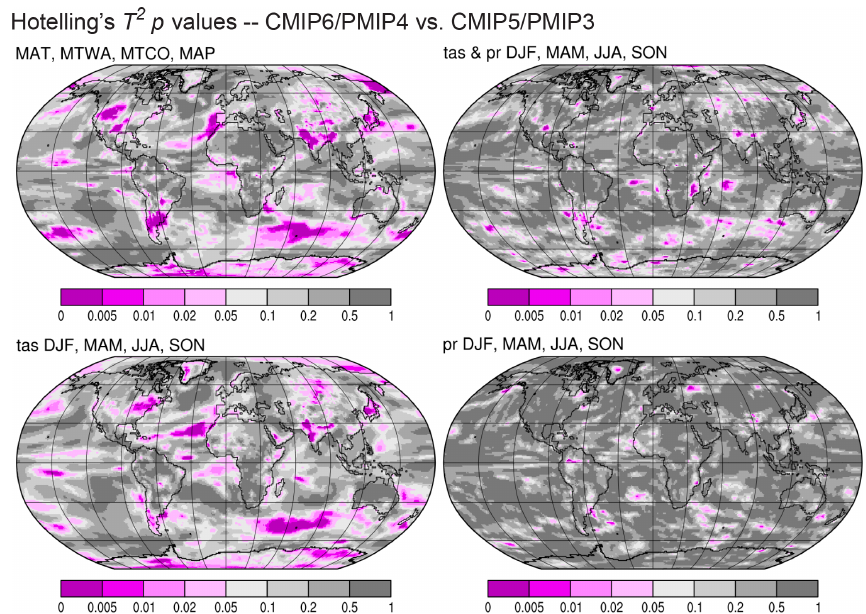
Figure 11. Maps of the p values of Hotelling’s T 2 test (Wilks, 2011) comparing the PMIP4-CMIP6 and PMIP3-CMIP5 ensembles. Four different combinations of the key variables analysed here are assessed (given in the top left above the panels). Values less than 0.05 would ordinarily be considered to be significant, but the total number of such values on each individual map does not exceed the false discovery rate. Harrison et al. (2015) presents equivalent analysis comparing PMIP3-CMIP5 with PMIP2-CMIP3 (using the variables in the top left